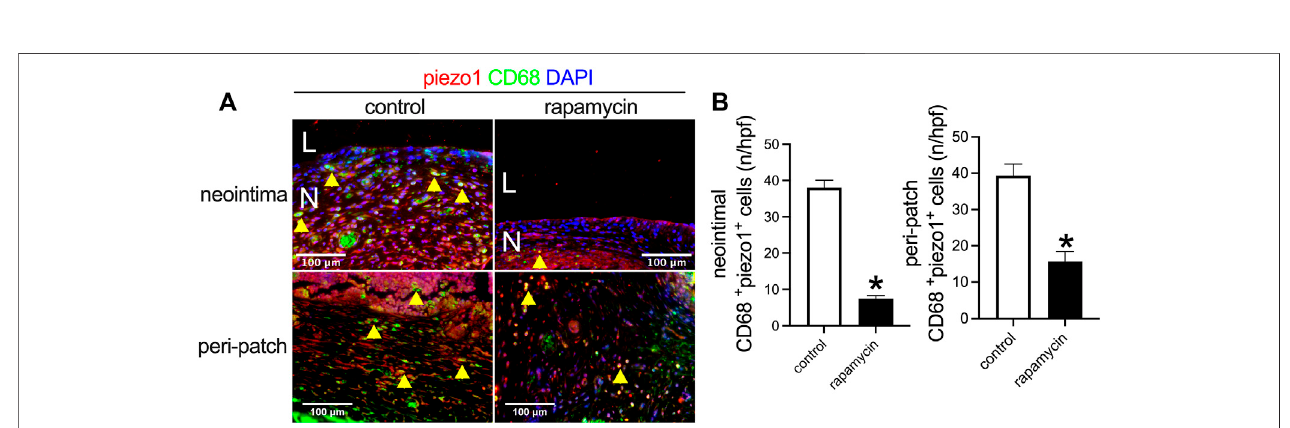
FIGURE 7 | Piezo1 expression after wood patch venoplasty. (A) Immuno fl uorescence showing CD68 (green), piezo1 (red), and DAPI (blue) in the neointima; scale bar100 μ m;yellowarrowheadsshowCD68andpiezo1dual-positivecells;N,neointima;L,lumen; n =3. (B) BargraphsshowingCD68andpiezo1dual-positivecellsin the neointima (* p = 0.0001, t -test) and the adventitia (* p = 0.0018, t -test); n = 3.